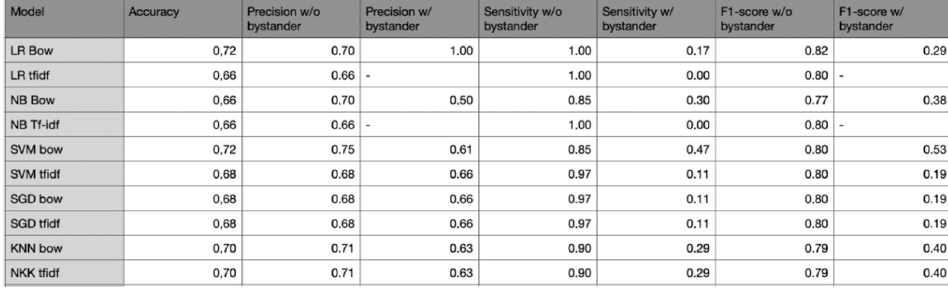
Figure 17. Results of the different models using full descriptions.